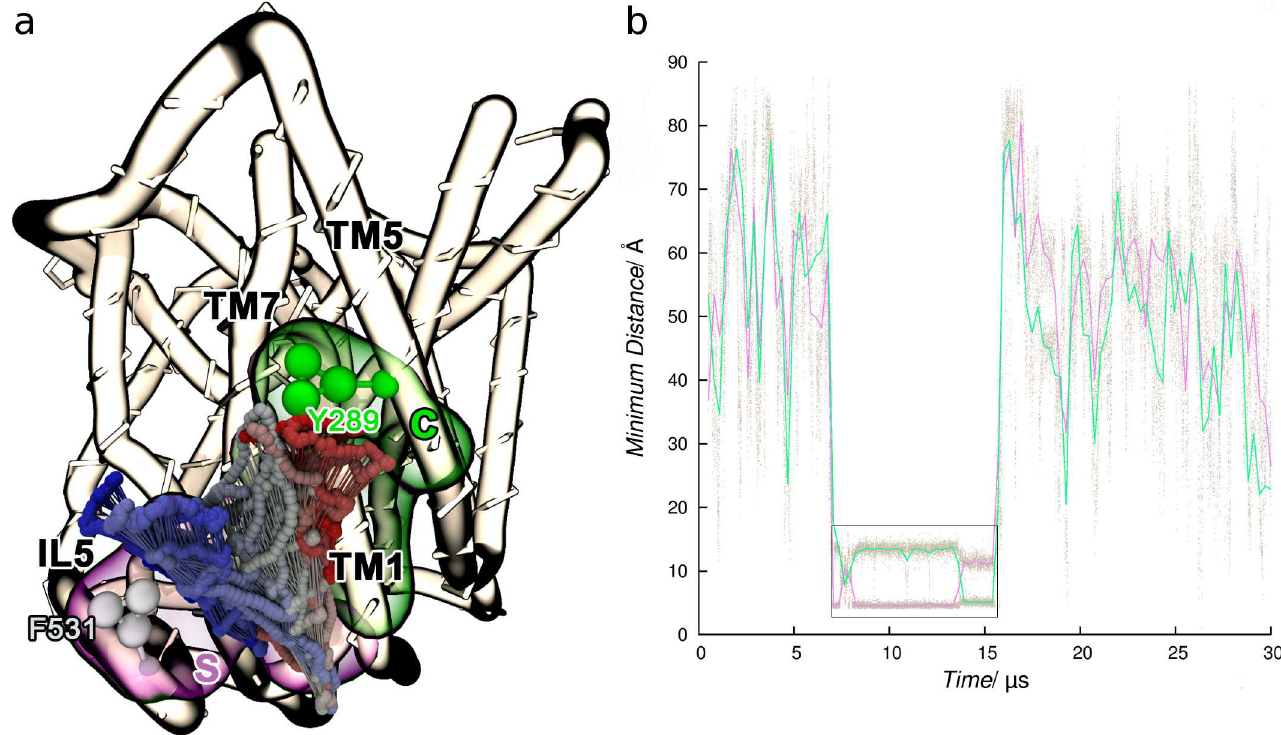
Fig 9. Cholesterol hopping from site S to C. ( a ) The cholesterol moleculeis colored accordingto simulationtime. ( b ) Time series of the minimum distancebetweencholesterol and the outliers F531 (site S, purplecurve) and Y289 (site C, green curves).